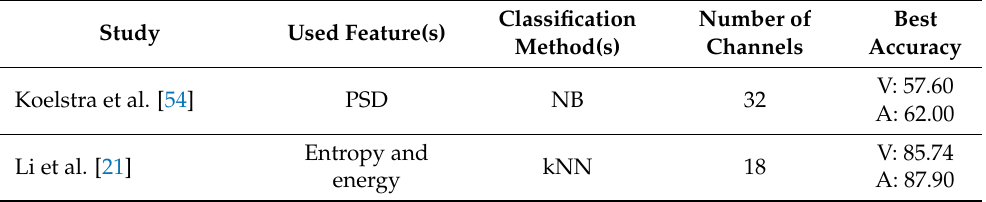
Table 4. Comparison with other studies with reduced channel set on DEAP